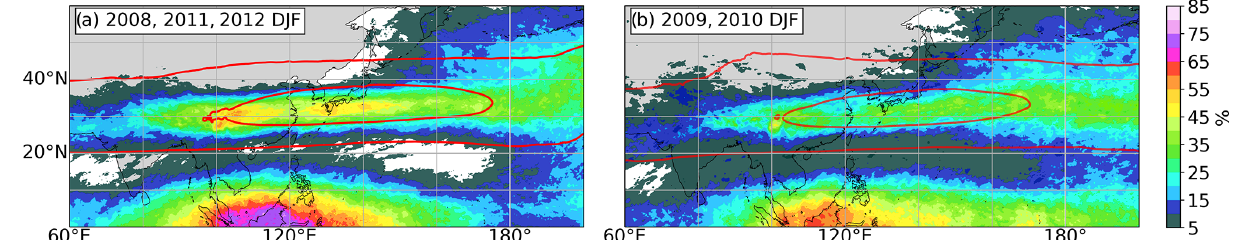
Figure 12. As in Fig. 7a but for a smaller geographical section, averaged over selected DJF seasons of (a) west-located EAJS core years (2008, 2011, and 2012) and (b) normally located EAJS core years (2009 and 2010). For further details see text and Wu and Sun